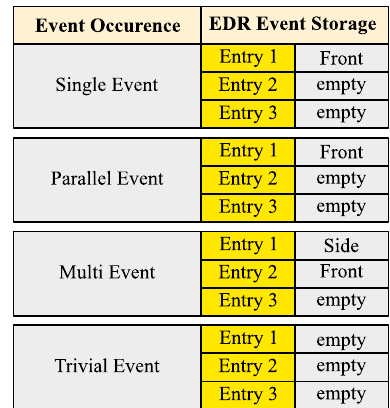
Figure 5. EDR event handling—possible cases: ( a ) single event; ( b ) parallel event; ( c ) multi event; ( d ) trivial event.